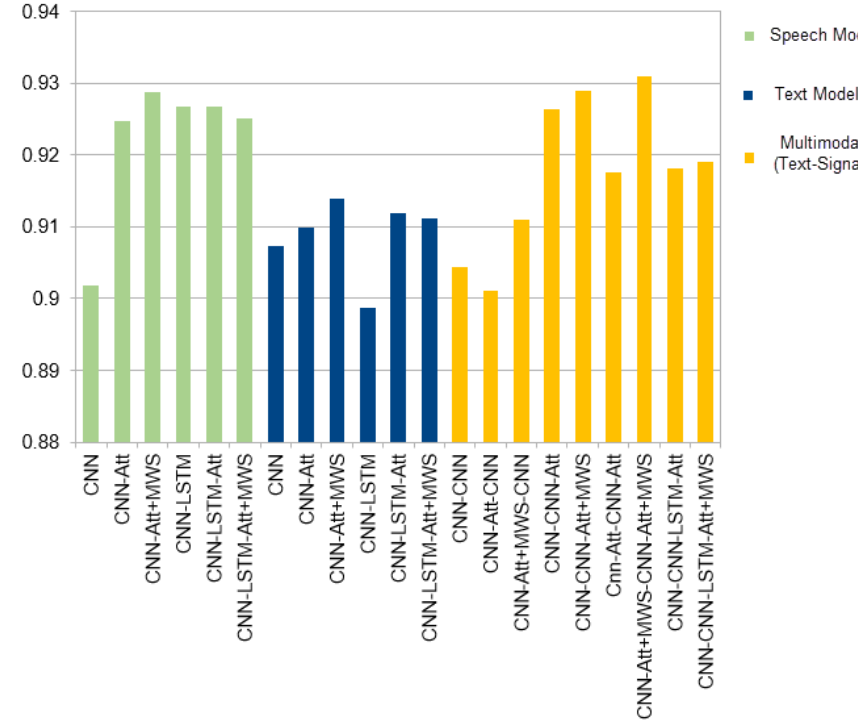
Figure 3. Modeling Approaches.